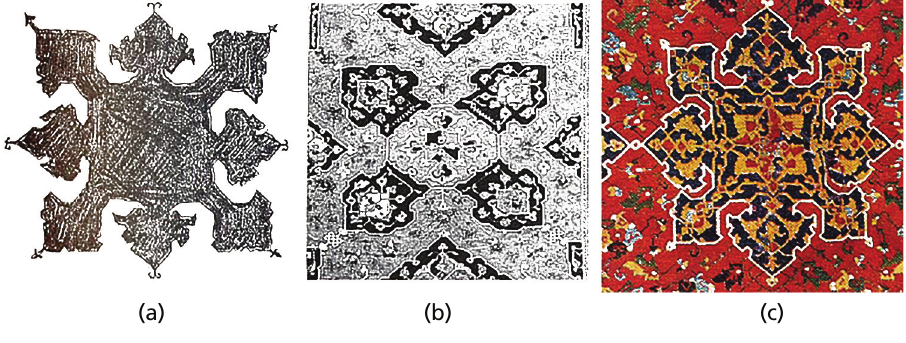
Figure 4. ( a ) a study of shape by Alexander; ( b ) carpet detail; ( c ) carpet detail color. Source: { Foreshadowing }